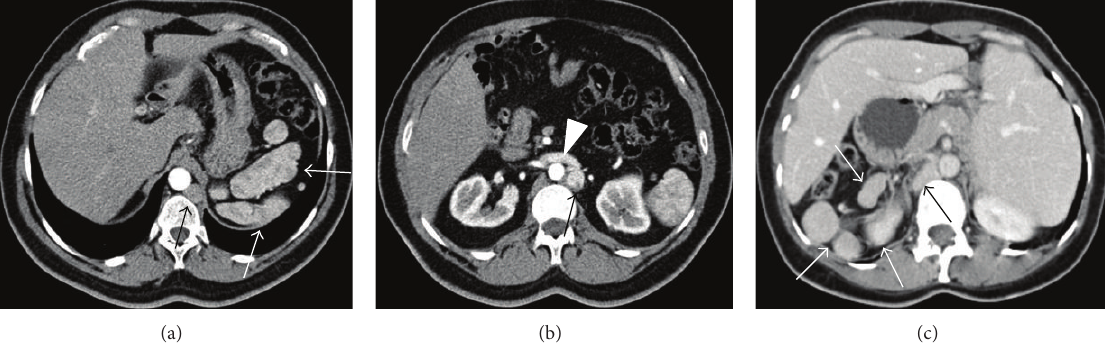
Figure 9: Heterotaxy syndrome in 48-year-old male (a), (b) and 49-year-old female patients (c). Axial contrast enhanced CT images (a), (b) show polysplenia (white arrows) at left upper quadrant which have heterogenous enhancement pattern on arterial phase as splenic tissue, azygos continuation (black arrow) of the inferior vena cava, and right renal vein draining into the azygos vein (arrowhead). Intrahepatic portion of the inferior vena cava is absent. Axial contrast enhanced CT image (c) shows, polysplenia at right upper quadrant (white arrows), absence of spleen at its normal location, liver located at midline related to situs ambiguous, and dilated azygos vein (black